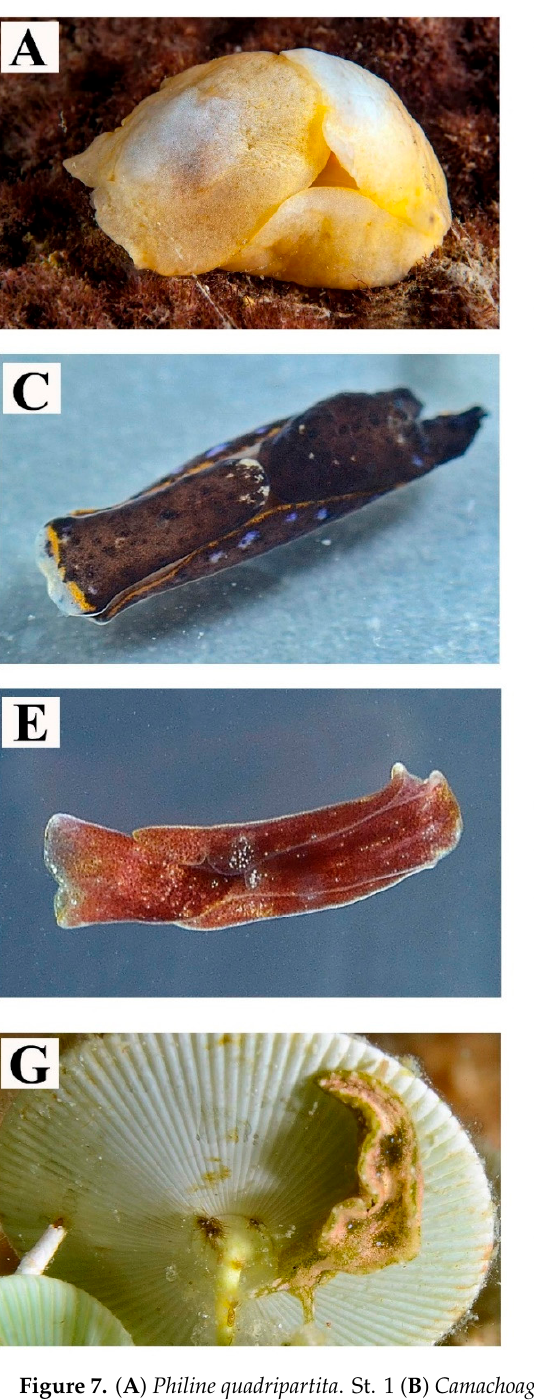
Figure 7. ( A ) Philine quadripartita . St. 1 ( B ) Camachoaglaja africana . St. 7 ( C ) Camachoaglaja africana . St. 22 Figure 7. A. Philine quadripartita . St. 1 B. Camachoaglaja africana. St. 7 C. Camachoaglaja africana. St. 22 D. ( D ) Philinopsis depicta . St. 10 ( E ) Melanochlamys wildpretii . St. 7 ( F ) Haminoea cf. orteai. St. 22 ( G ) Elysia Philinopsis depicta . St. 10 E. Melanochlamys wildpretii . St. 7 F. Haminoea cf. orteai. St. 22 G. Elysia gordanae . gordanae . St. 11 ( H ) Elysia gordanae . St. St. 11 H. Elysia gordanae . St. 11.